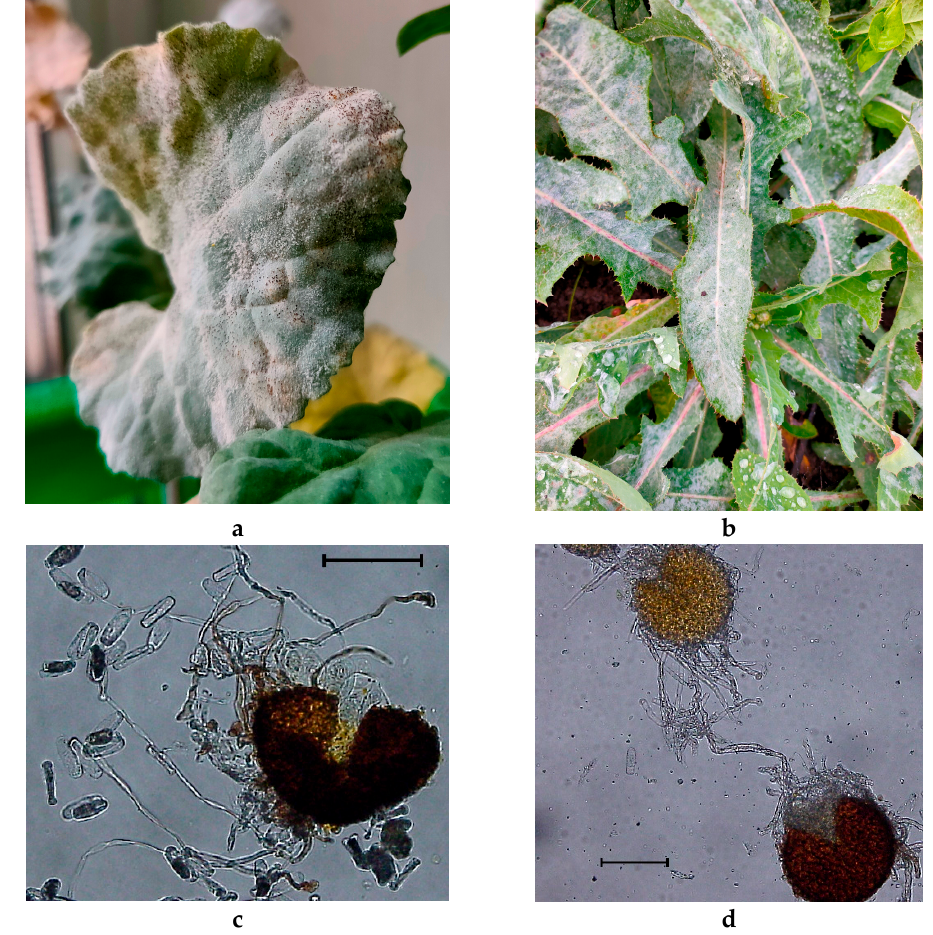
Figure 1. Powdery mildew in: B. napus ( a , c ) and S. oleraceus ( b , d ). The scale corresponds to 100 µ m.